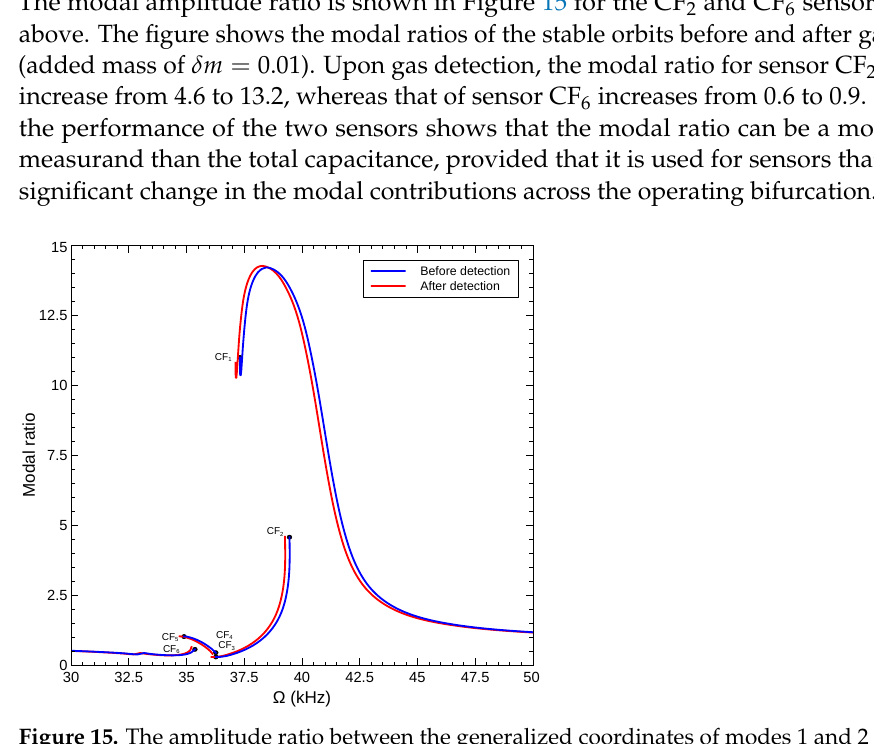
Figure 15. The amplitude ratio between the generalized coordinates of modes 1 and 2 ( P q two sensors modes of an arched microbeam with an initial rise of w o = 6µm under the voltage waveform V DC = V AC =